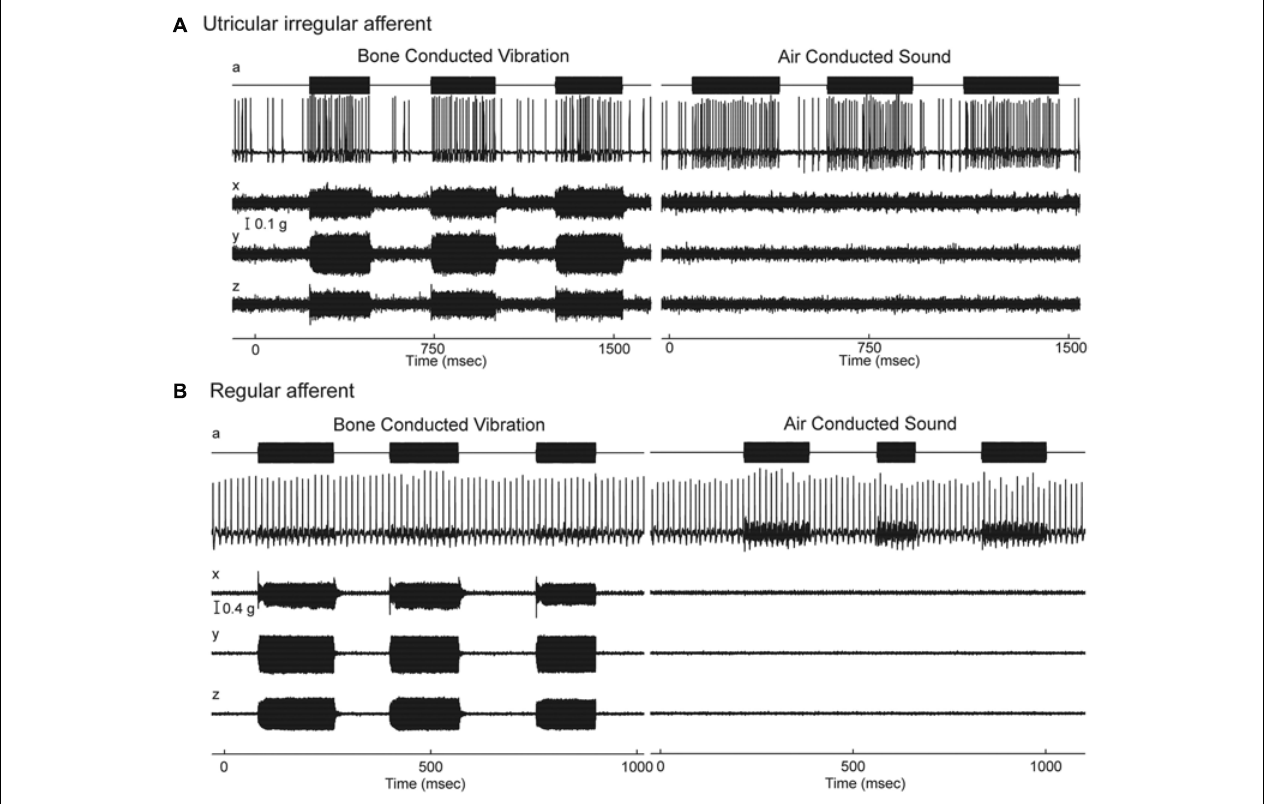
FIGURE 4 | Resting discharge pattern and response to stimulation of an irregular and a regular afferent. (A) Time series of the one irregular otolith neuron during stimulation by 500 Hz bone-conducted vibration (BCV) and air-conducted sound (ACS). The top trace (a) shows the command voltage, indicating when the stimulus is on. The second trace shows the action potentials by extracellular recording. The three bottom traces ( x, y, z ) show the triaxial accelerometer recording of the stimulus. The neuron is clearly activated by both BCV and ACS. (B) Time series of a regular semicircular canal neuron during stimulation by 500 Hz BCV and ACS as above. The regular discharge is seen before the stimulus onset. The stimuli have a far greater amplitude than in panel (A) , but there is no evidence of activation of this regular neuron by these strong stimuli. Reproduced from Curthoys and Vulovic (2011) with permission of Springer.